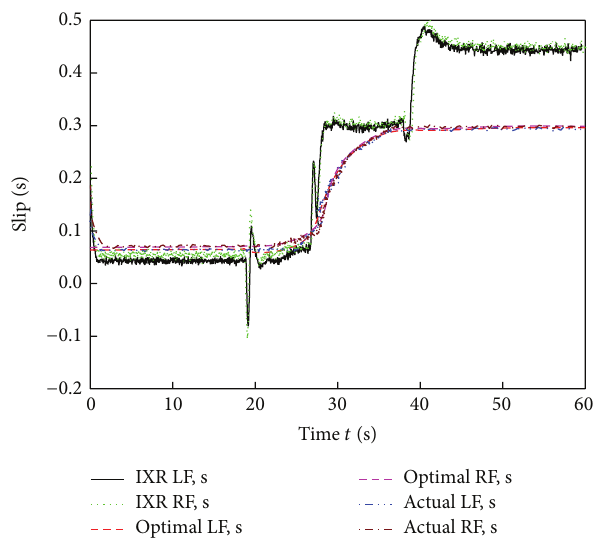
Figure 11: Middle-wheels slip ratio comparison of different control strategy.